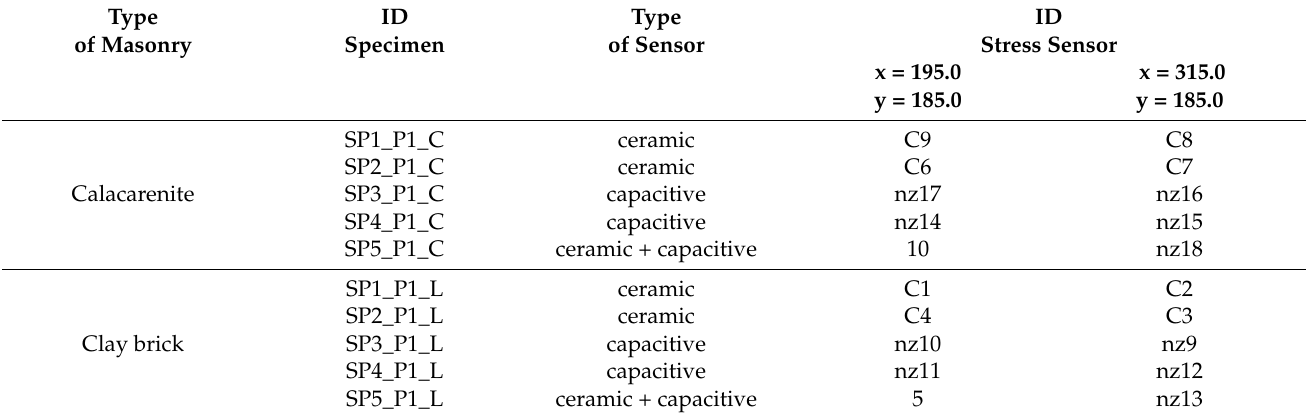
Table 1. Specimens and sensors post-installed with method P1 (dimensions in mm).